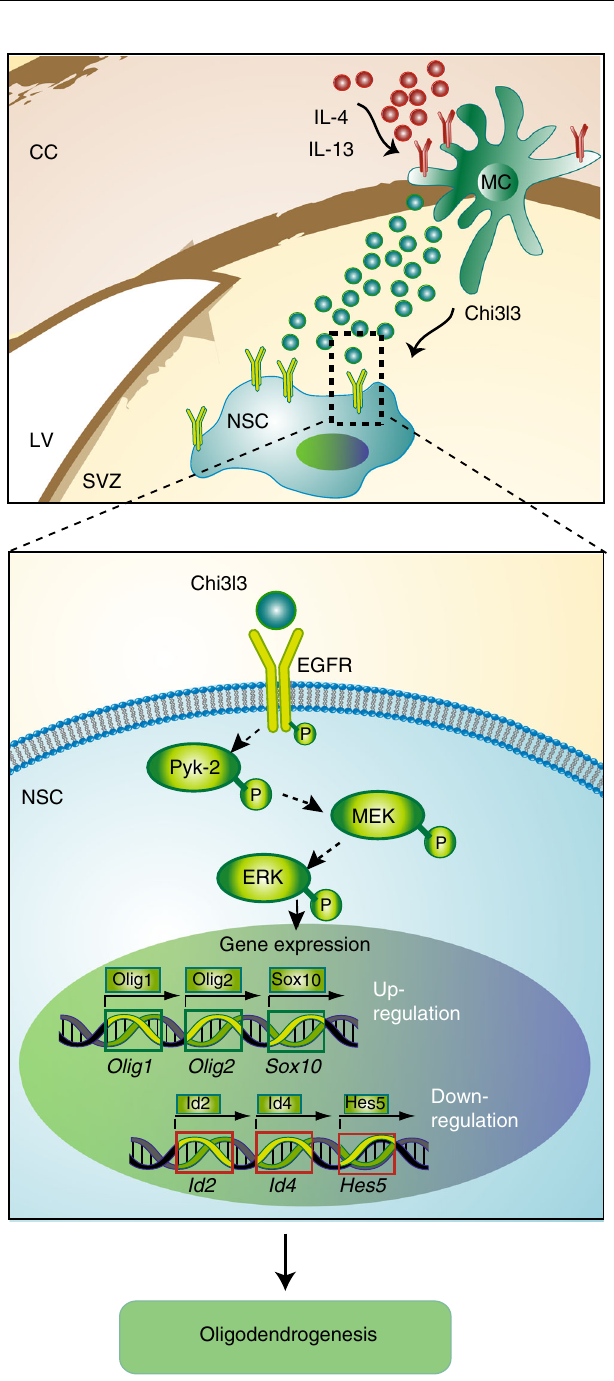
Fig. 8 Proposed model of Chi3l3-induced oligodendrogenesis. In the central nervous system, Chi3l3 is expressed and secreted by alternatively activated myeloid cells (MC), including resident microglia and in fi ltrating macrophages. These cells are located in the corpus callosum (CC) and in close proximity to the subventricular zone (SVZ) of the lateral ventricle (LV). Chi3l3 binds to epidermal growth factor receptor (EGFR) on the surface of endogenous neural stem cells (NSCs) and activates MEK/ERK signaling and a pro-oligodendrogenic transcription factor pattern in a Pyk2- dependent manner, leading to